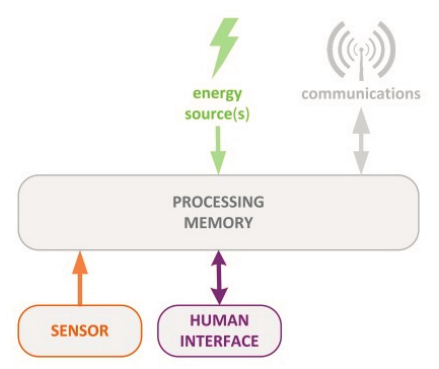
Figure 1. Smart Signal